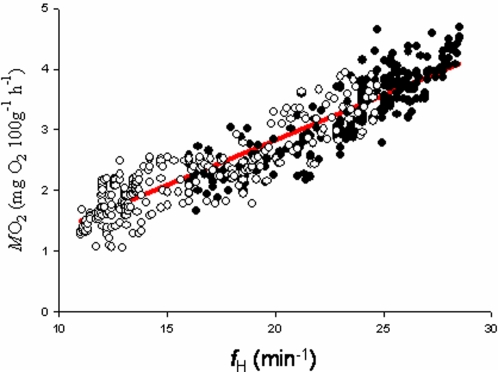
The seasonal relationship between heart rate (f
H) and oxygen consumption (MO2) in N. coriiceps.
Data were recorded in June (winter, open circles), and January (summer, closed circles). Fish were collected from sea-cages and immediately placed into a closed circuit respirometer, oxygen consumption and f
H were recorded simultaneously. ANOVA of fitted regression lines demonstrated that the slopes were not significantly different between summer and winter, and therefore a single regression line was fitted to explain the relationship between f
H and MO2 throughout the year (0.148 X–0.14, r2 = 0.86, N = 6 fish, n = 559 observations).